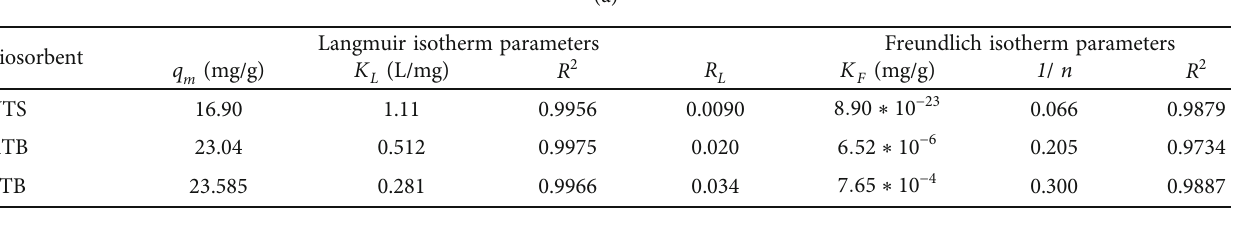
Table 3: Isotherm and kinetic constants for Cr (VI) adsorption onto unmodi fi ed and modi fi ed Te ff straw biosorbent.